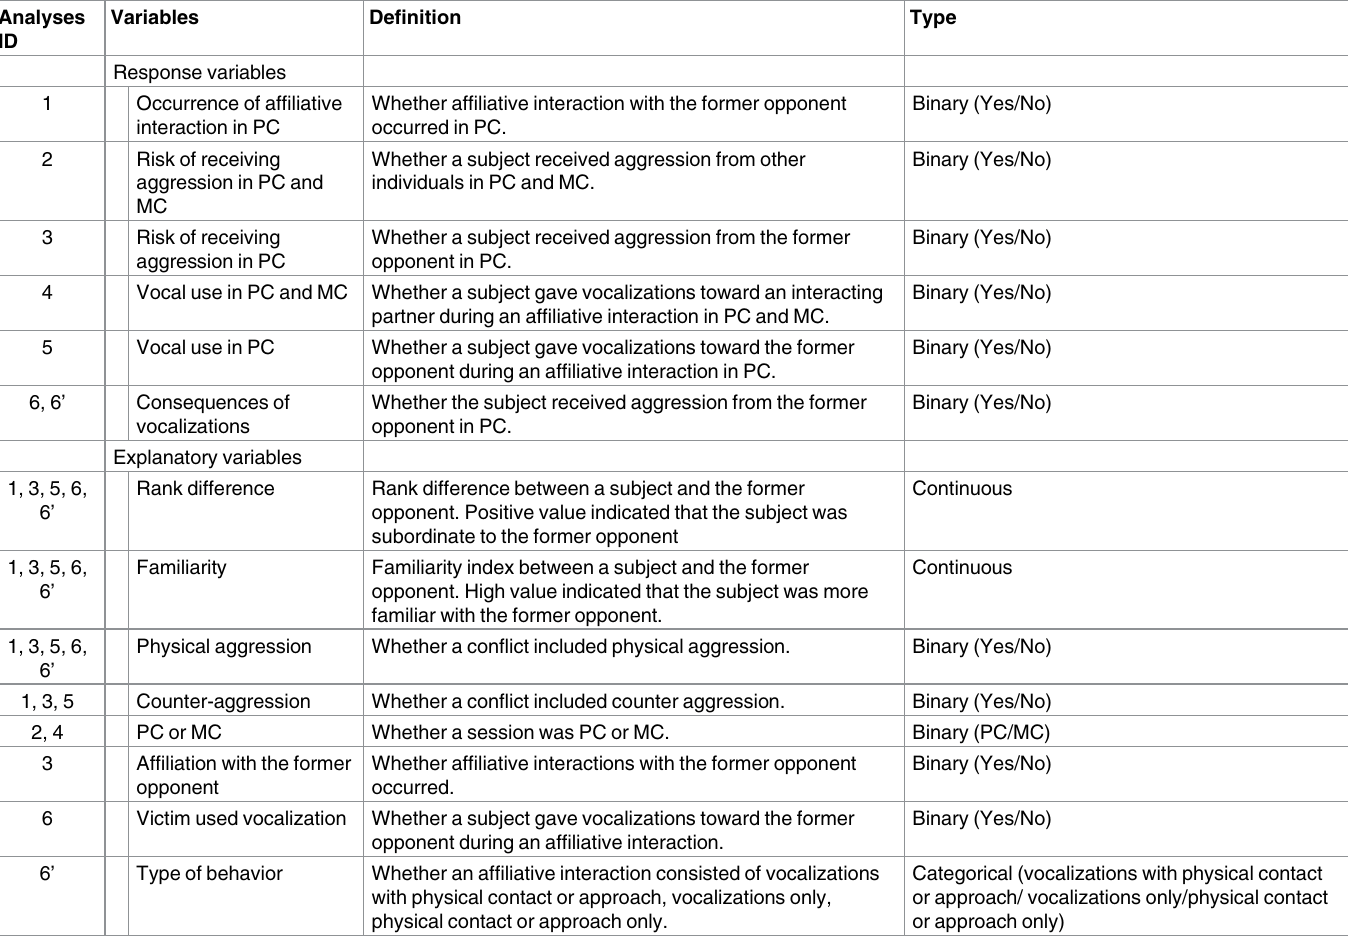
Table 1. Definition for response and explanatory variables used in